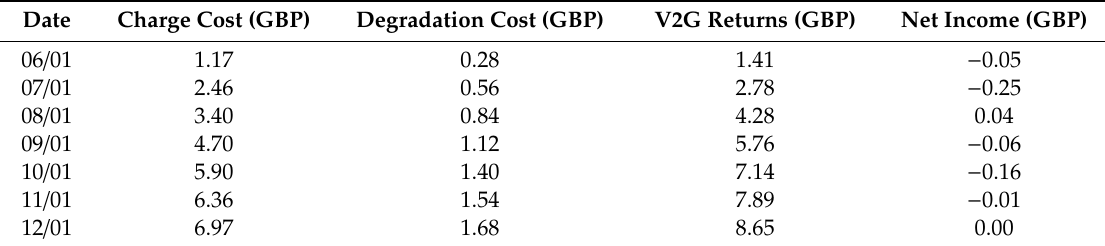
Table 3. Cumulative financial results of the V2G simulation across a week (6 January 2020–